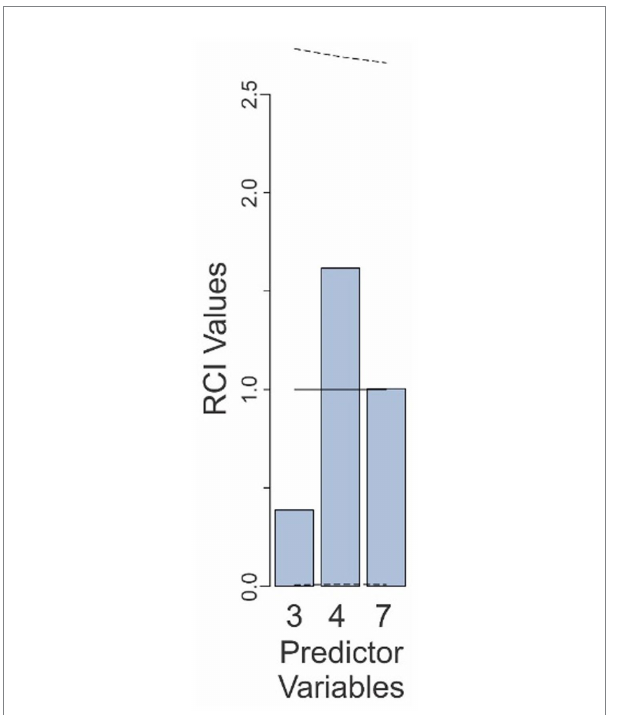
FIGURE 6 Relative contributions of various predictors to the fit of the Final Model in Experiment 3. The predictor variables are those that are retained in the Final Model and are numbered as in Table 3. The solid line denotes the expected contributions of the various predictors. The dashed lines denote the upper and lower 95% confidence intervals (uncorrected), empirically determined from the data. See text for